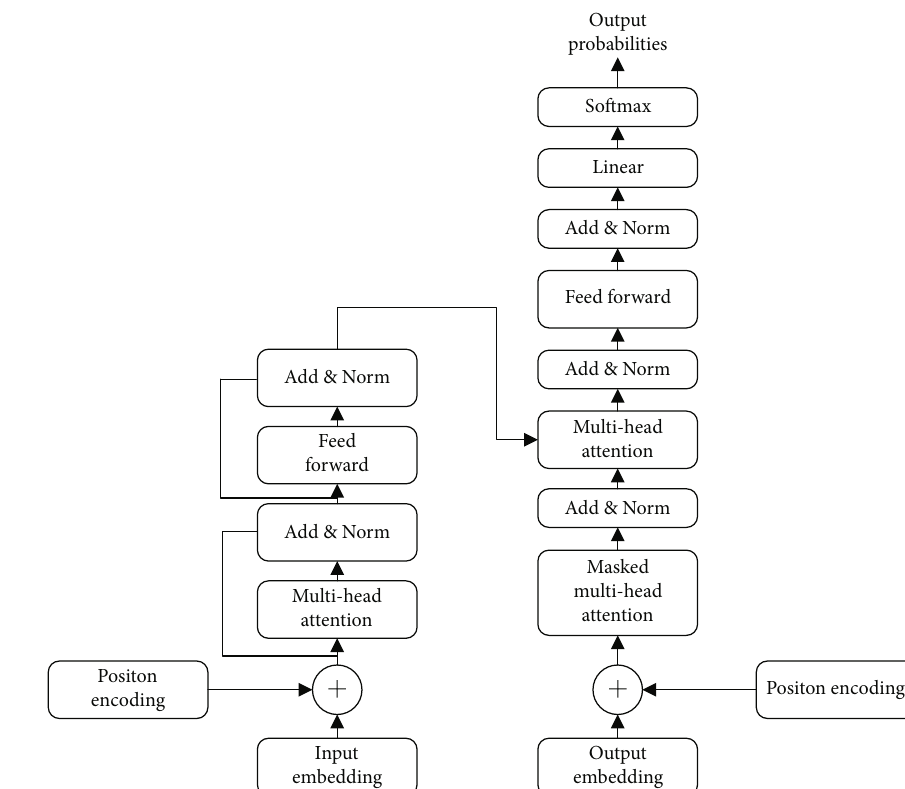
Figure 1: Transformer